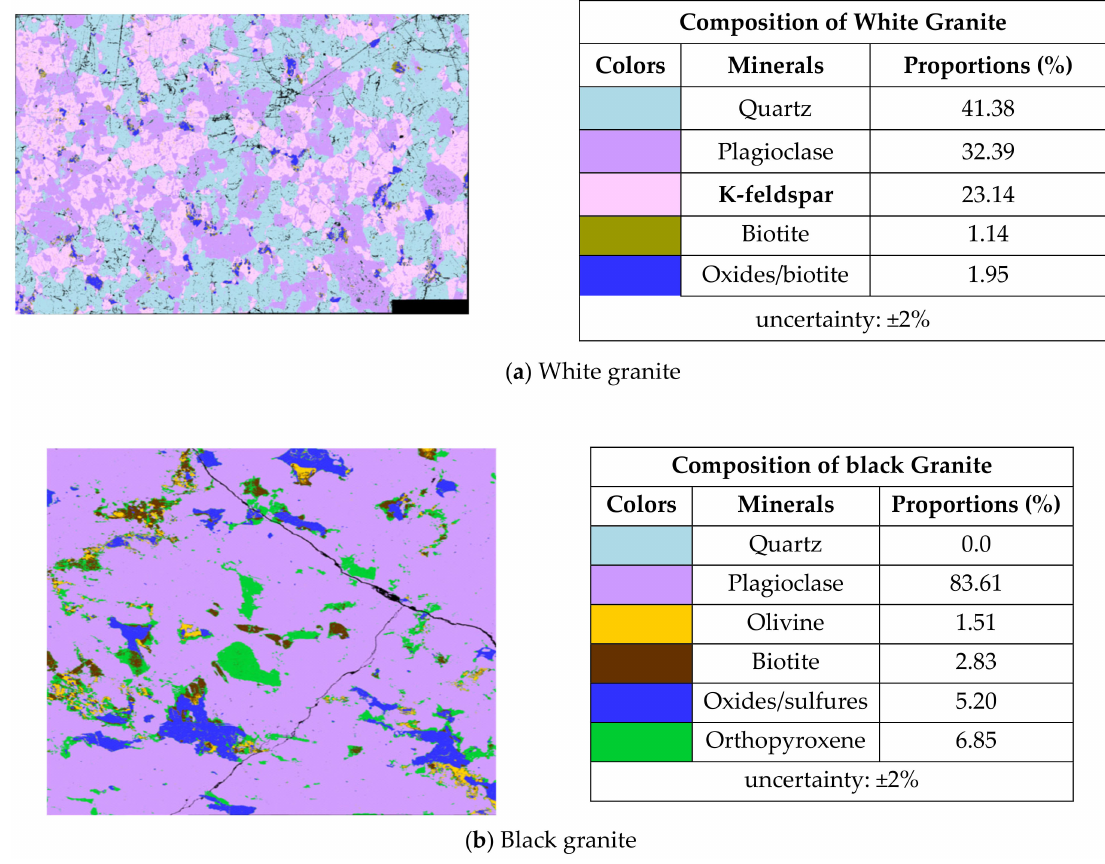
Figure 5. Mineral distribution of white and black granite samples obtained from SEM analysis